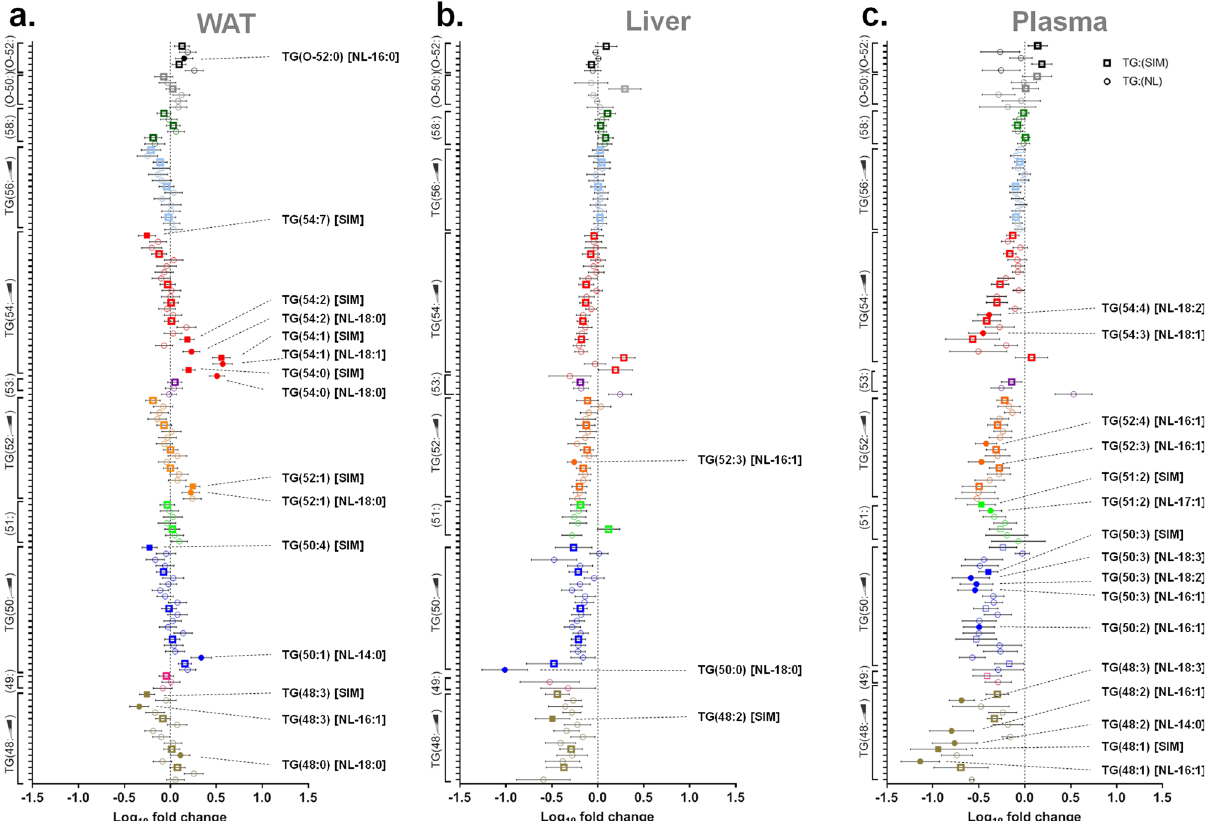
Fig. 5 Trim28 adi-KO alters triglyceride composition in WAT. Lipidomics in gonadal fat pads (WAT), liver, and plasma from female mice fed a chow diet for 24 weeks. Triglyceride (TG) species from ( a ) WAT, ( b ) liver, and ( c ) plasma. Triglyceride species were ordered into subclasses based on the combined FA carbon chain length (i.e., TG48 = 3× FAs containing 16 C each), then sorted vertically within those subclasses according to increasing carbon bond saturation (in the order indicated by the scale bar). For a complete list of triglycerides analyzed, see Supplementary Data Table 1. Squares represent data for single ion monitoring mode (SIM) of lipid species; circles represent species with annotation of a single FA side chain as determined by neutral loss analysis (NL). Data are expressed as log 10 fold change from Trim28 WT mice as mean ± SEM, n = 11 WT and n = 11 KO. Individual comparisons were analyzed using Student ’ s two-tailed unpaired t tests. Closed symbols represent species that were statistically signi fi cant ( p < 0.05) compared to WT. TG triacylglycerol, NL neutral loss, O-TG alkyl